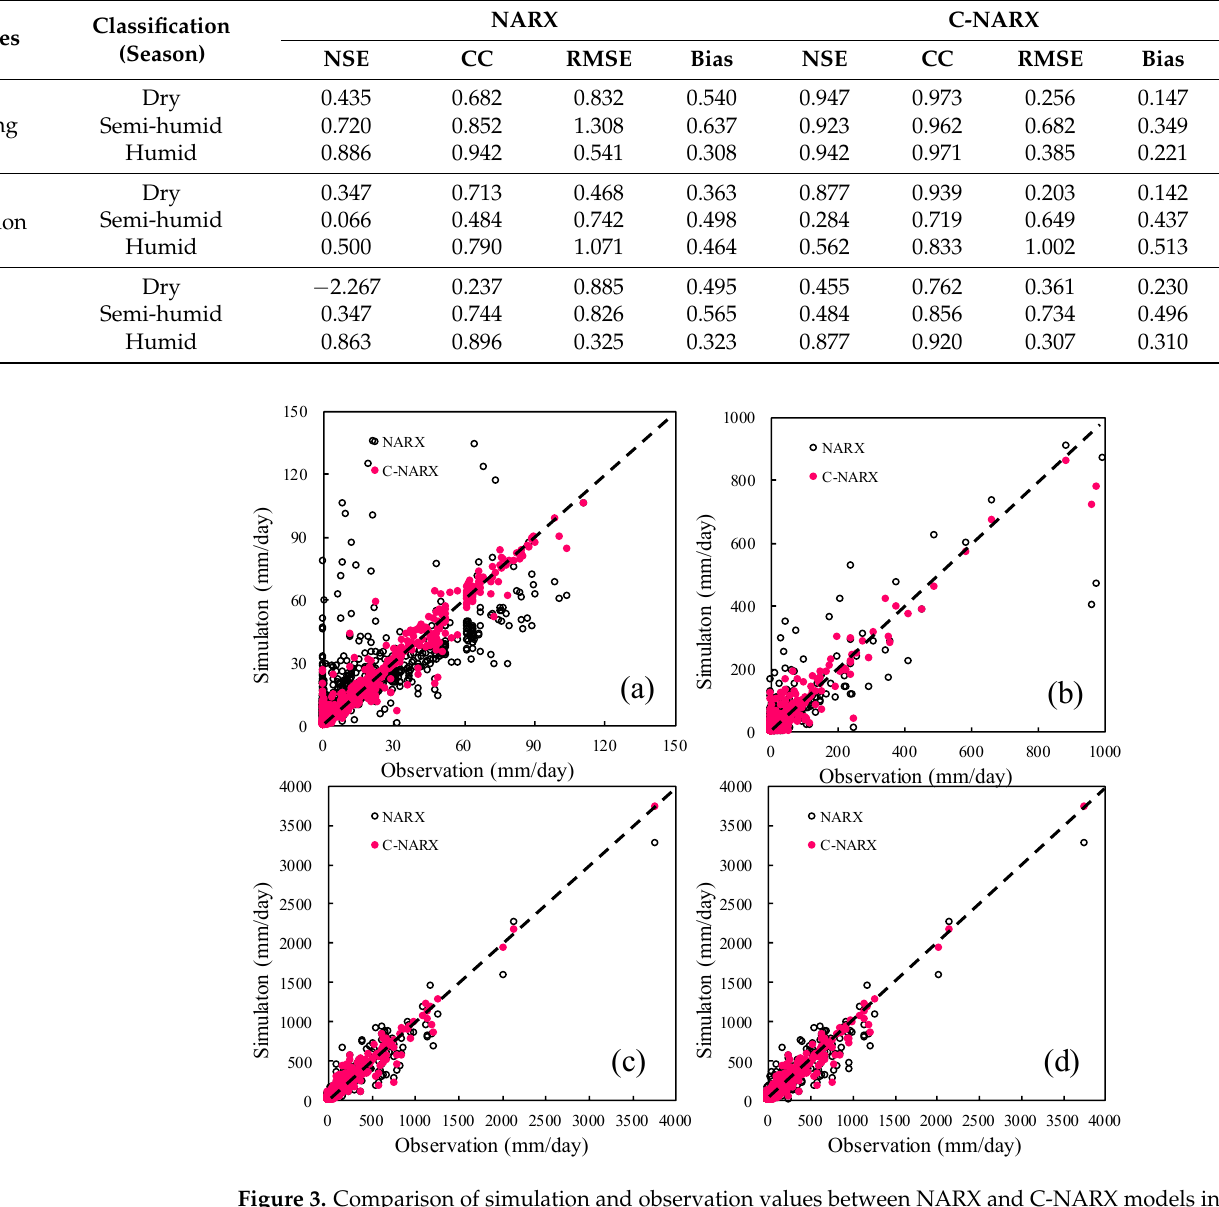
Table 3. Performance of the NARX and C-NARX models based on the runoff classification.